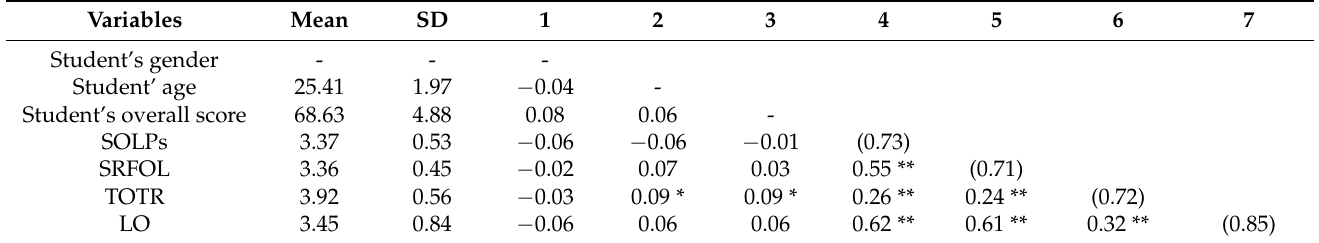
Table 4. Descriptive statistics, correlation, and the square root of average variance extracted scores.